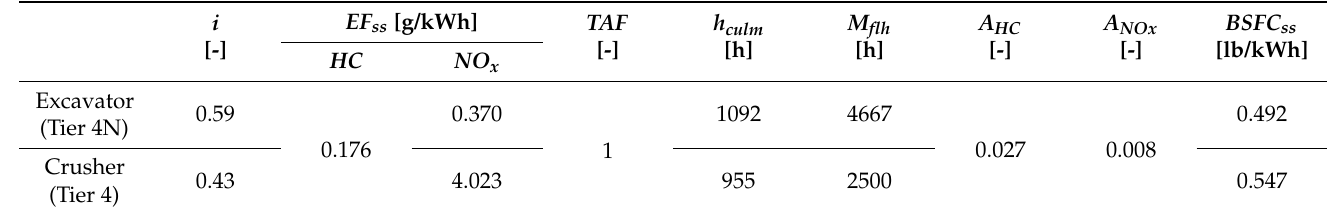
Table 7. Indicators used in the calculations for the phase of C 1, C 3.1, C 3.2 i C 2.1. Own elaboration based on